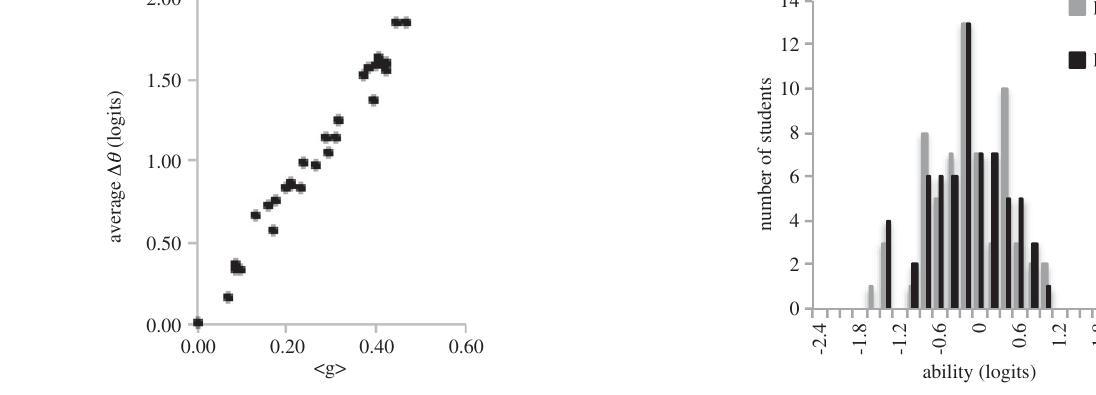
students in the LSCI national data set.